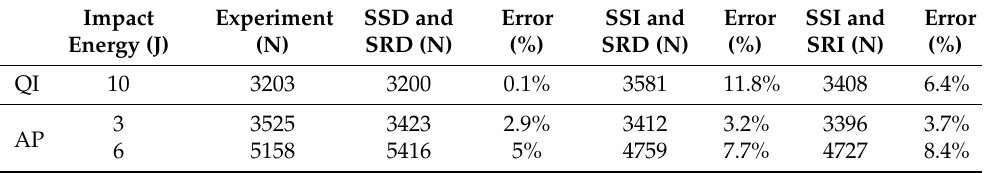
Table 3. Maximum contact force comparison of the experimental and numerical results.